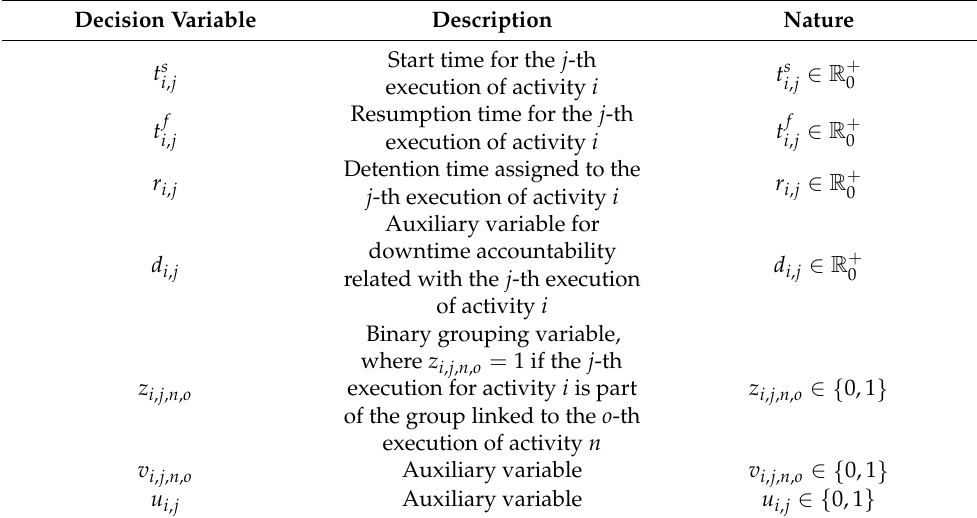
Table 3. Summary and description of decision